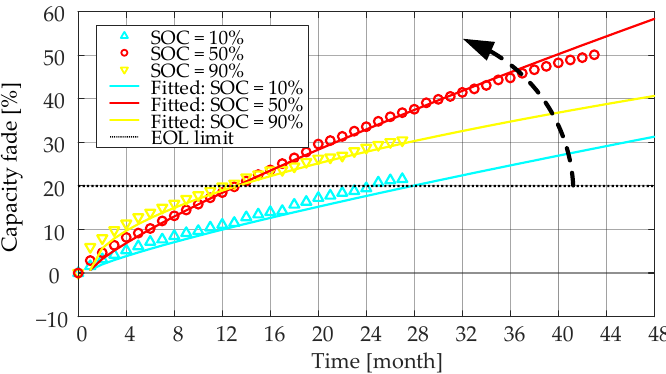
Figure 9. The relationship between the curve fitting coefficients and the corresponding storage temperature. ( a ) Exponential relationship between a T and T , ( b ) Power relationship between b T and T .